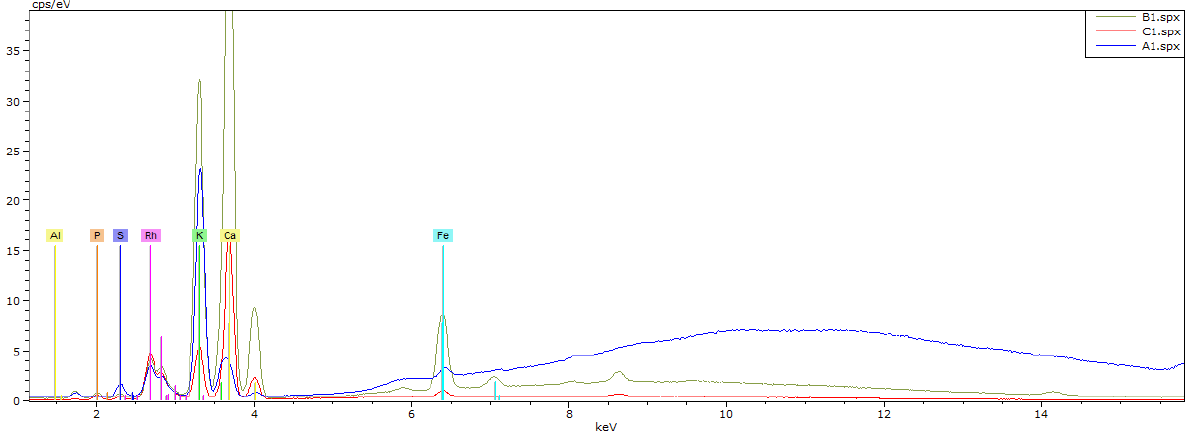
Figure 10. XRF analysis spectrum of CARBOSORB NC 1240 ® (A1), AMBIOTON ® (B1), and RE- CHAR ® (C1).